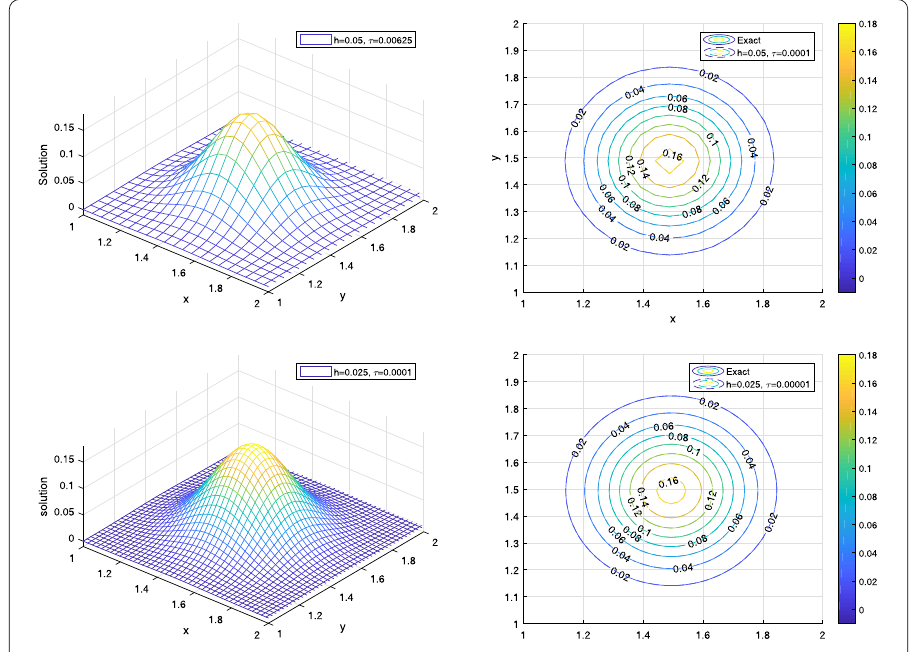
Figure 2 Numerical solutions and their contour obtained by the DHOC-ADI scheme using h x = h y = 0.05, τ = 0.00625 (top) and h = 0.025, τ = 0.0001 (bottom)